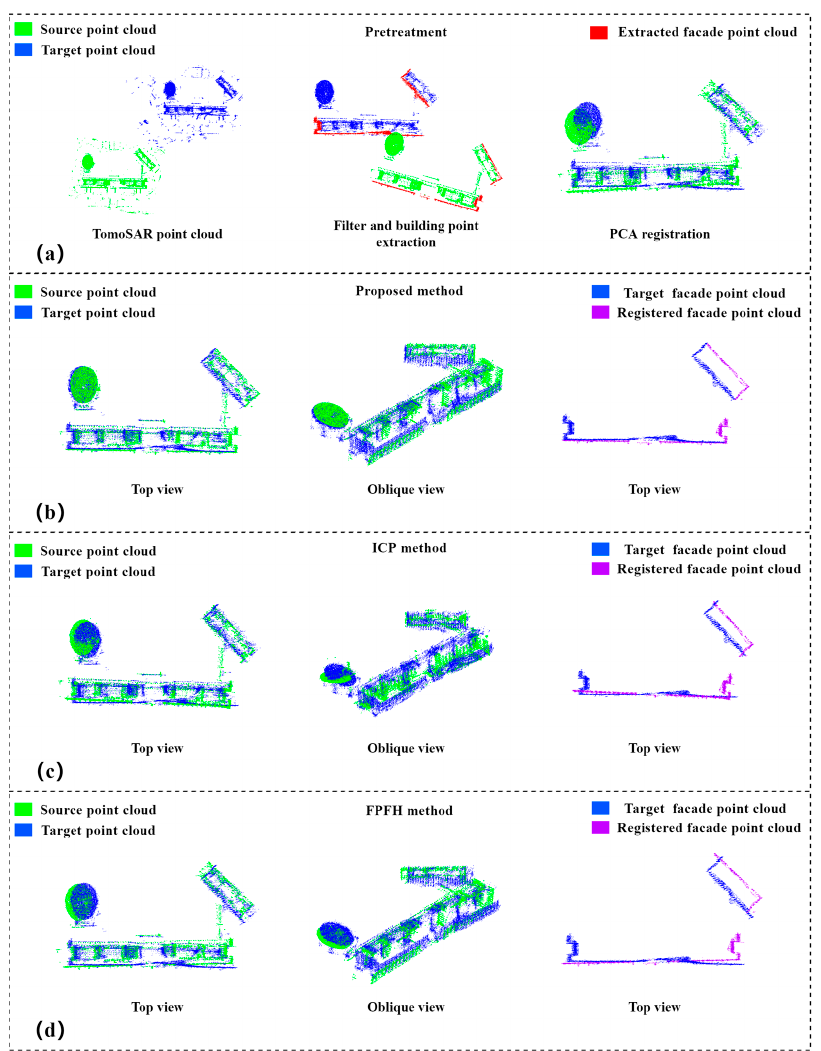
Figure 10. Alignment results of homologous TomoSAR point cloud of Experiment 1: ( a ) raw data and preprocessing of experimental data, including statistical filtering, extraction of DoPP-based facade points, density clustering, and PCA-based coarse alignment; ( b ) top and oblique views of the alignment results of the method in this paper and top view of the aligned facade points; ( c ) top and oblique views of the alignment results of ICP algorithm and top view of the aligned facade points; ( d ) top and oblique views of the alignment results of FPFH algorithm and top view of the aligned facade points.